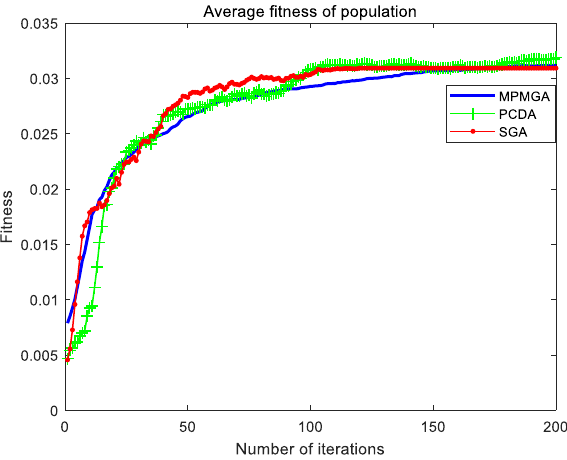
Figure 17. Evolutionary comparison diagram of population average fitness.